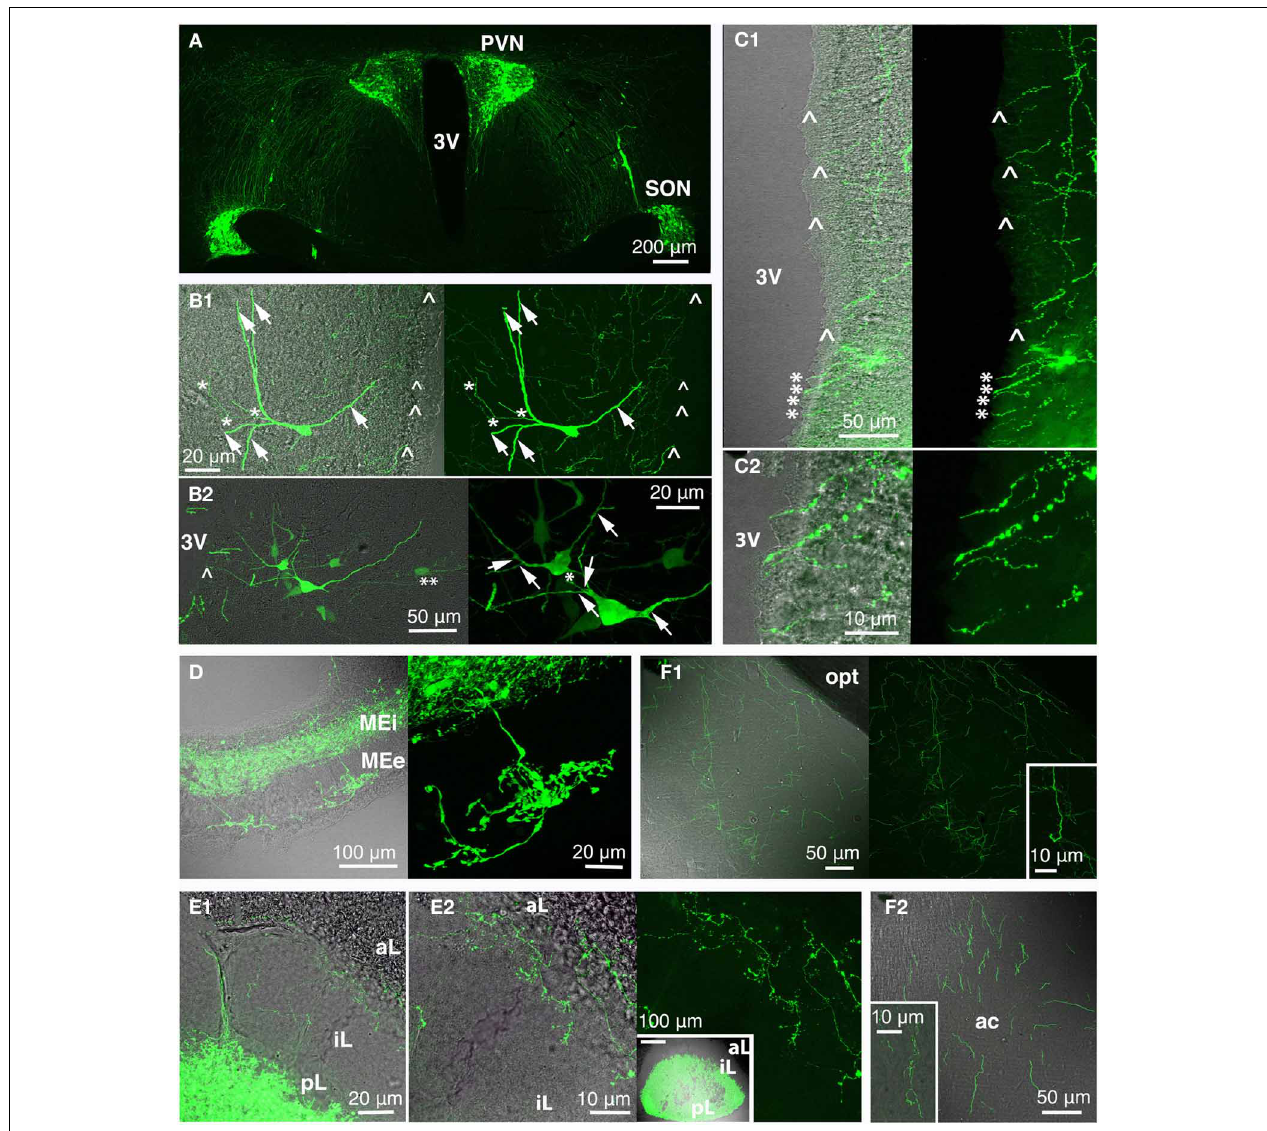
FIGURE 4 | Rat oxytocin (OT) neurons residing in PVN and SON (and AN; not depicted here) were visualized with the green fluorescence-protein Venus in rats using recombinant adeno-associated virus technique, thereby revealing the complexity of the central OT system (A) as well as of single OT neurons (B; arrow: dendrite/dendritic collateral; asterisk: likely axon/axonal collateral; double asterisk: contact to second OT cell; arrow head: fiber below ventricular ependyma). The 3rd ventricle is surrounded by OT fibers (C) that extend below the ventricle-lining ependymal layer (arrow head) or reach the ventricle lumen (asterisk; C2 magnification of ventral part of the 3rd ventricle shown in C1 ). Release of OT into the circulation occurs via the median eminence (internal and external layer; D )